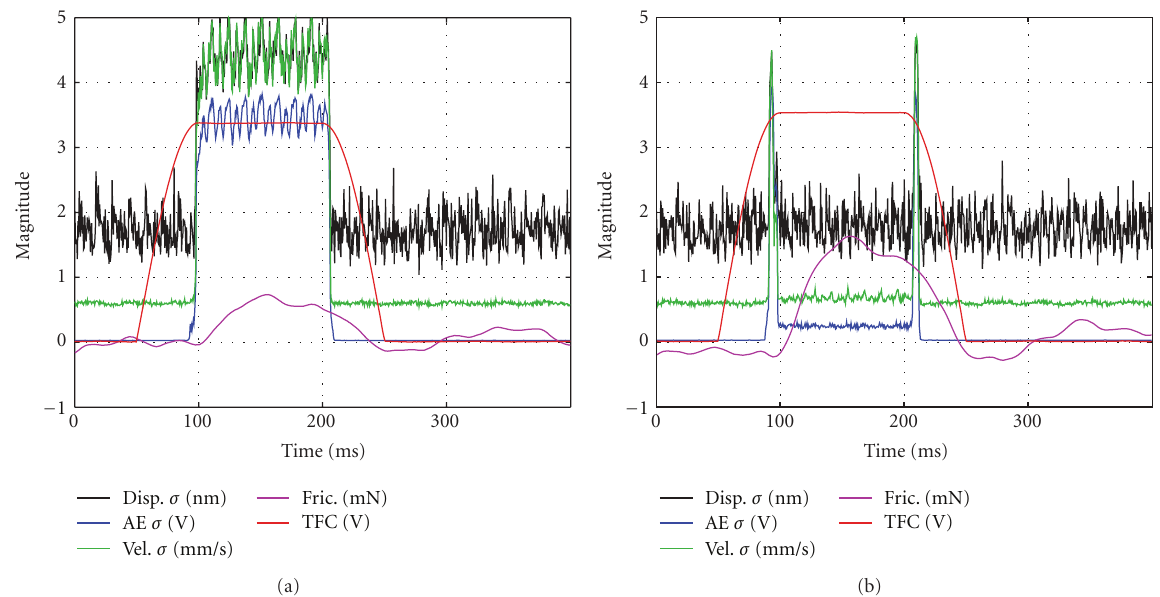
Figure 8: Time history of TFC power, vertical displacement, vertical velocity, AE signal, and friction. (a) 10mW overpush, (b) 20mW overpush.